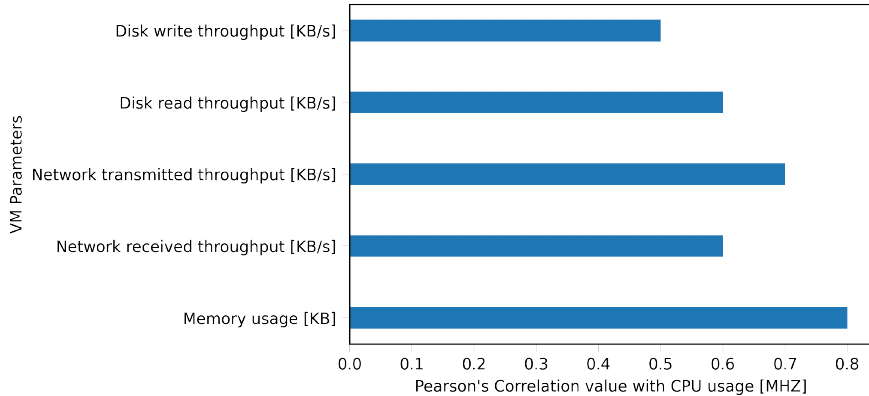
Figure 4. Pearson’s correlation of CPU usage with other VM parameters.